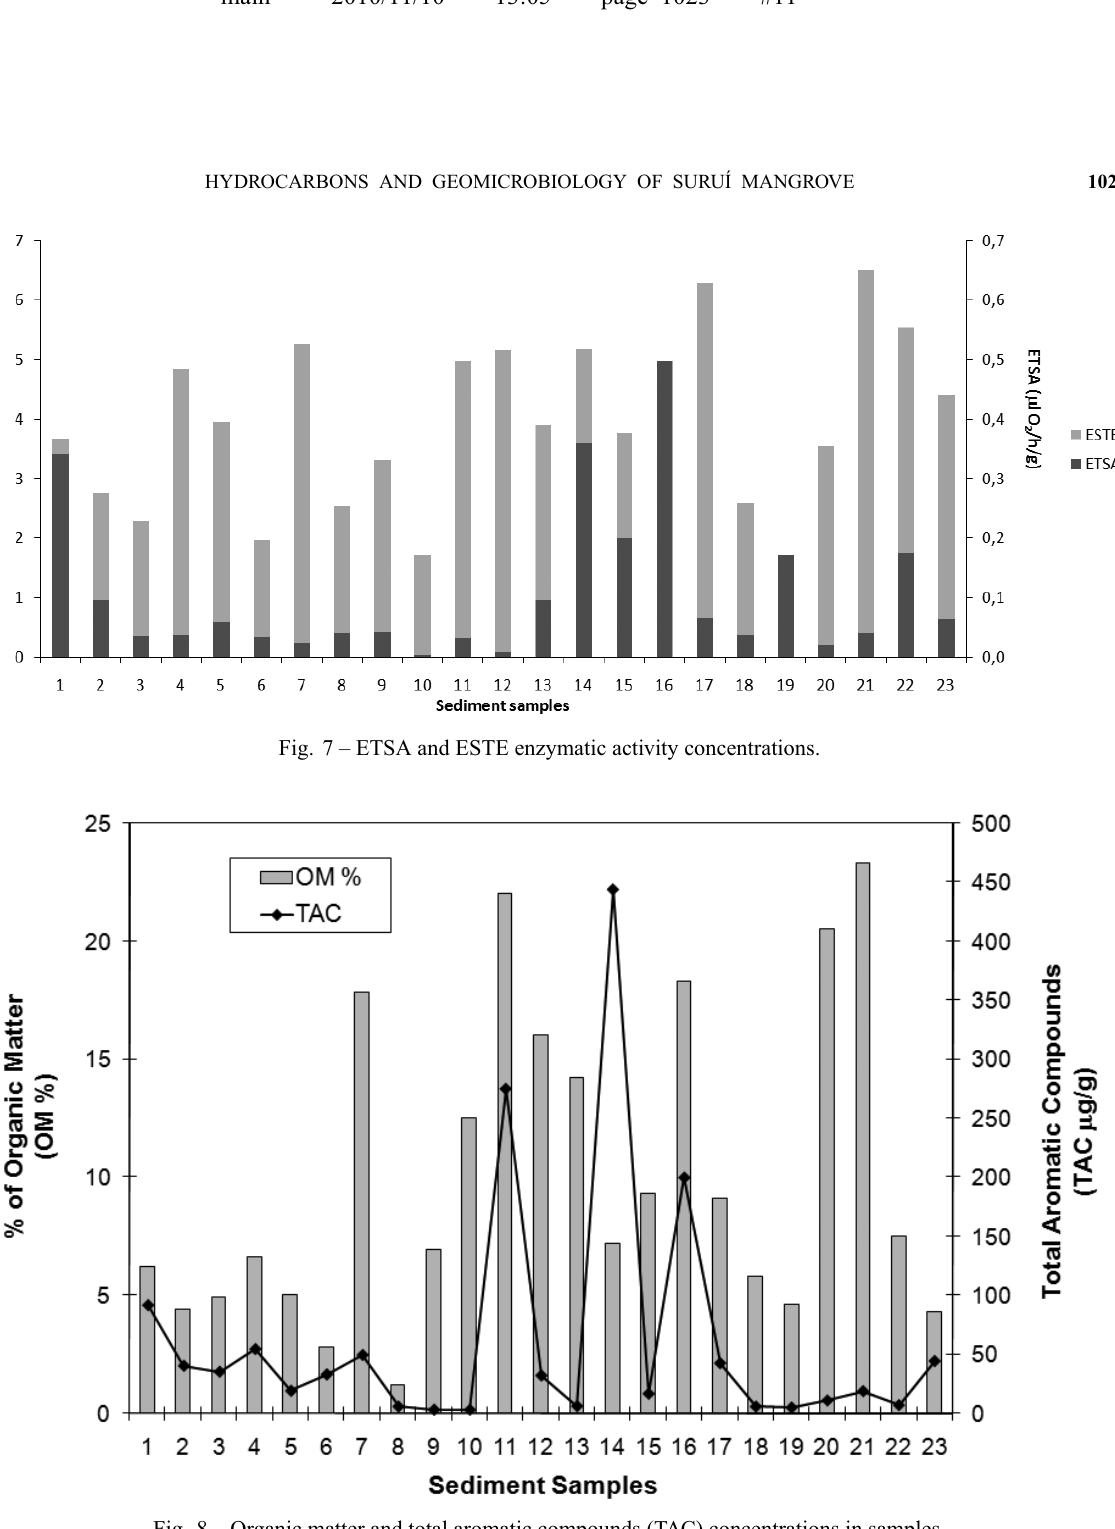
Fig. 8 – Organic matter and total aromatic compounds (TAC) concentrations in